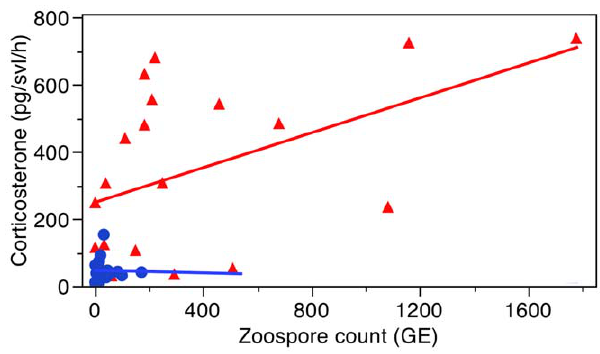
Figure 2. Correlation between corticosterone release rates and zoospore count. The correlation between corticosterone levels (pg/ svl/h) and Batrachochytrium dendrobatidis zoospore count (GE) for Alytes obstetricans (red triangles) and A. muletensis (blue circles).